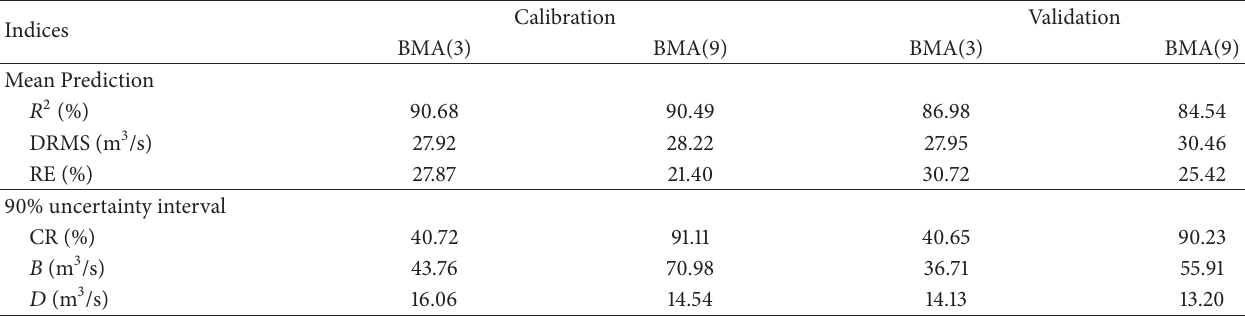
Table 3: The comparison of BMA(3) and BMA(9) in the mean prediction and 90% uncertainty interval for the whole flow series.